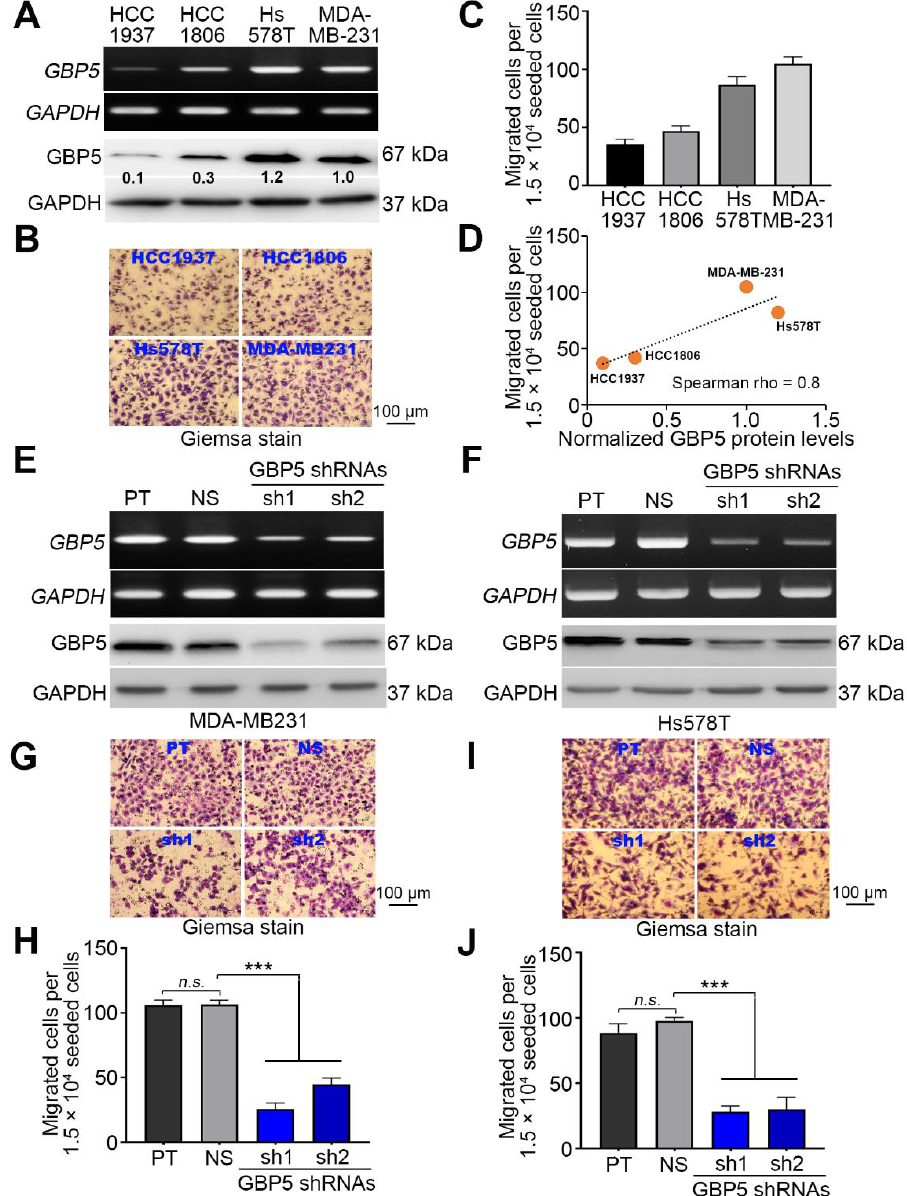
Figure 3. GBP5 knockdown suppresses the migration ability of TNBC cells. ( A ) The mRNA and protein levels of GAPDH and GBP5 detected by RT-PCR (upper panel) and Western blot (lower panel) analyses, respectively, in a panel of TNBC cell lines HCC1937, HCC1806, Hs578T and MDA-MB-231. ( B , C ) Geimsa staining ( B ) and the histogram ( C ) for the migrated cells of tested TNBC cell lines in Transwell cultivation for 4 h. ( D ) Dot plot for the correlation between normalized GBP5 protein levels, the inserts as shown Figure 3A, and migrated cell number in the tested TNBC cell line. The dashed line represents the regression line. ( E , F ) The mRNA and protein levels of GBP5 and GAPDH detected by RT-PCR (upper panel) and Western blot (lower panel) analyses, respectively, in parental (PT) MDA-MB-231 ( E )/Hs578T ( F ) cells and MDA-MB-231/Hs578T cells transfected with nonsilencing (NS) control shRNA or 2 independent GBP5 shRNAs. In ( A , E , F ), GAPDH was used as an internal control for experiments. ( G , J ) Geimsa staining ( G ) and ( I ) and the histogram ( H ) and ( J ) for the migrated cells of tested MDA-MB-231 ( G,H ) and Hs578T ( I,J ) cell variants in Transwell cultivation for 4 h. In ( C , H , J ), the error bars denote the data from three independent experiments presented as the mean ± SEM. A nonparametric Friedman test was used to analyze the statistical significance. The symbols “***” and “n.s.” denote p < 0.001 and not significant,